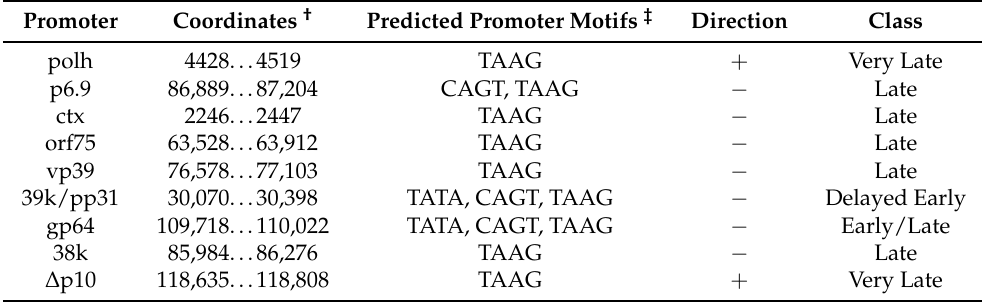
Table 1. AcMNPV genomic coordinates for promoters used in this